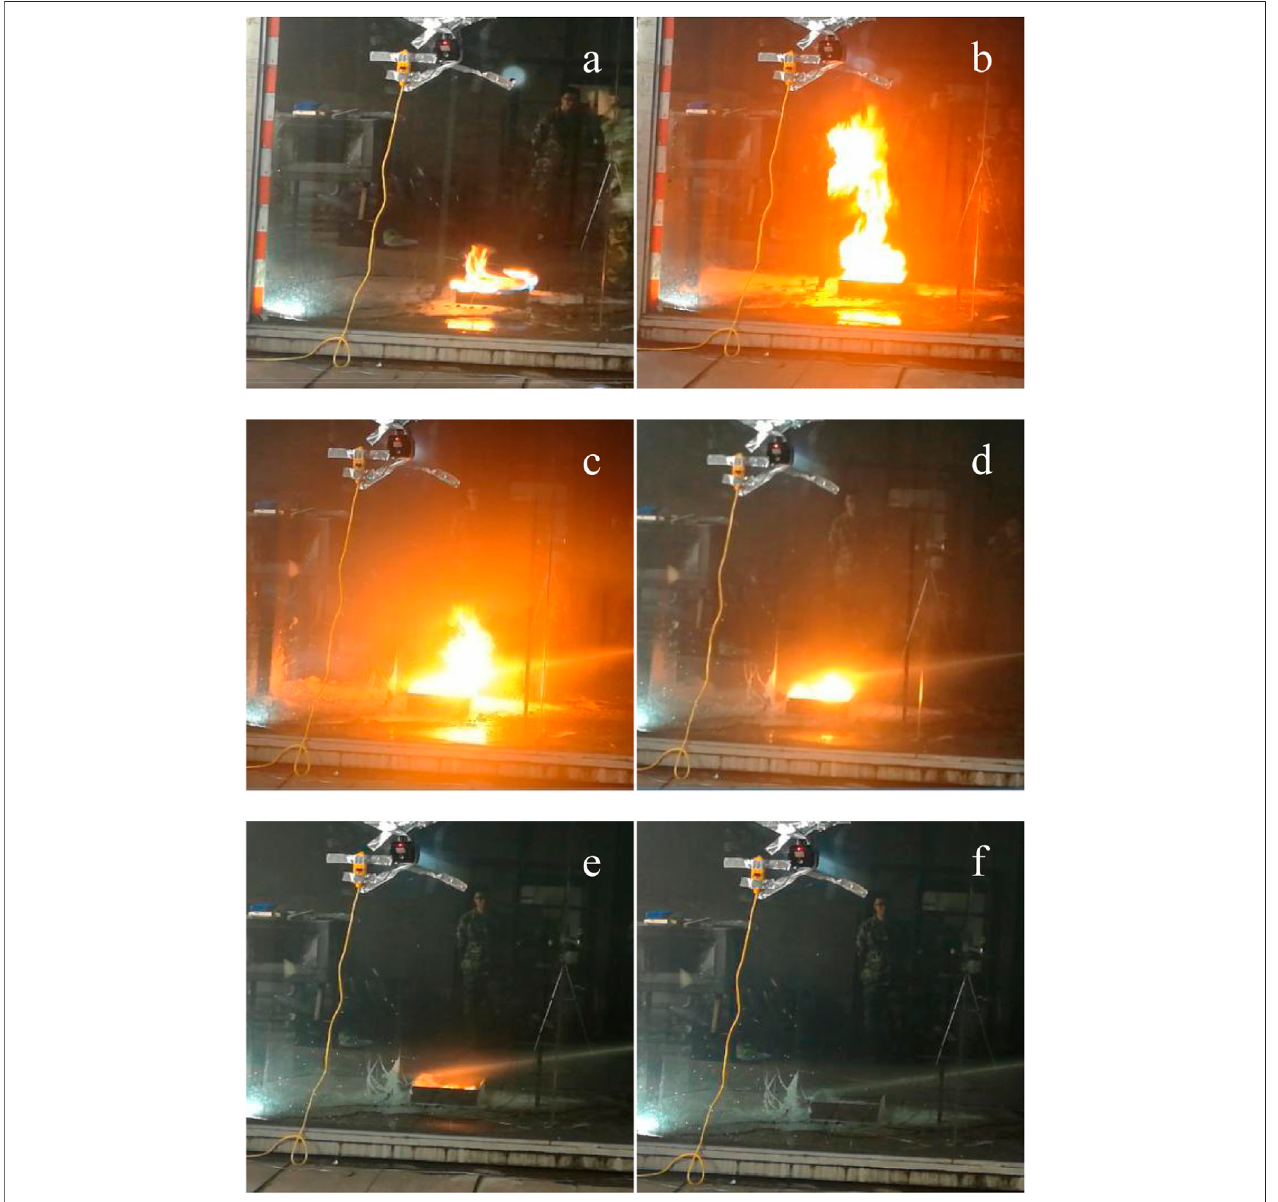
FIGURE 2 | Fire- fi ghting test with composite foam (A) ignite; (B) t (cid:2) 0 s; (C) t (cid:2) 20 s; (D) t (cid:2) 24 s; (E) t (cid:2) 26 s; (F) t (cid:2) 28